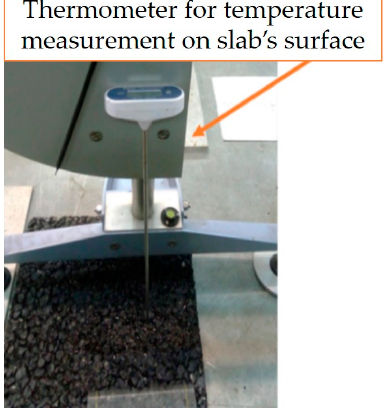
Figure 9. Temperature measurements on the specimen’s surface.